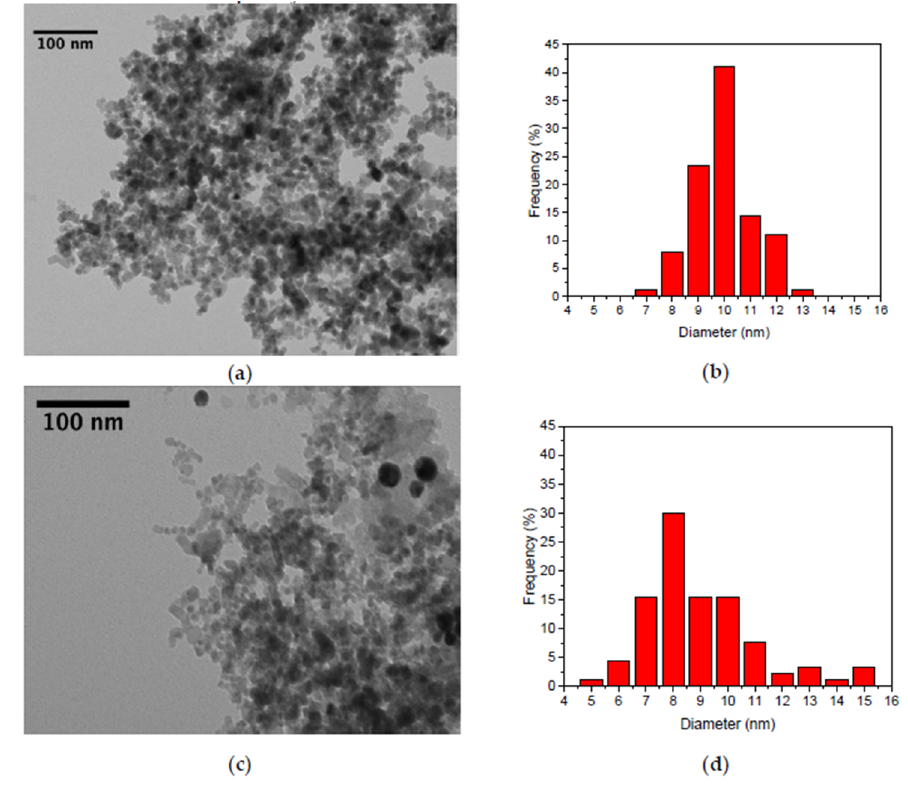
Figure 2. TEM picture of sample 21 ( a ) and particle size distribution obtained from picture analysis ( b ). TEM picture of sample 2 ( c ) and particle size distribution obtained from picture analysis ( d ) .